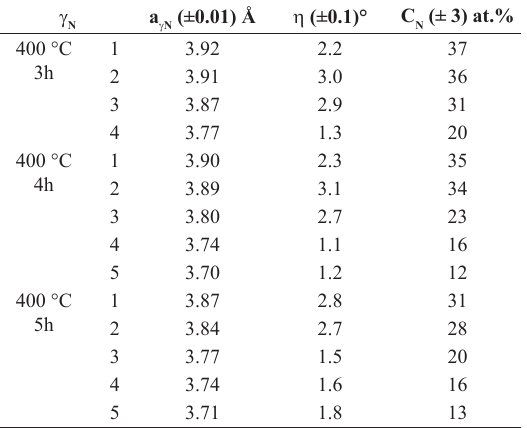
Table 3. Values for Lattice parameter ( a ), Distortion ( η ) and ) for each sublayer of the g phases used Nitrogen concentration ( C N N in DRX pattern fittings for samples nitrided at 400 °C.